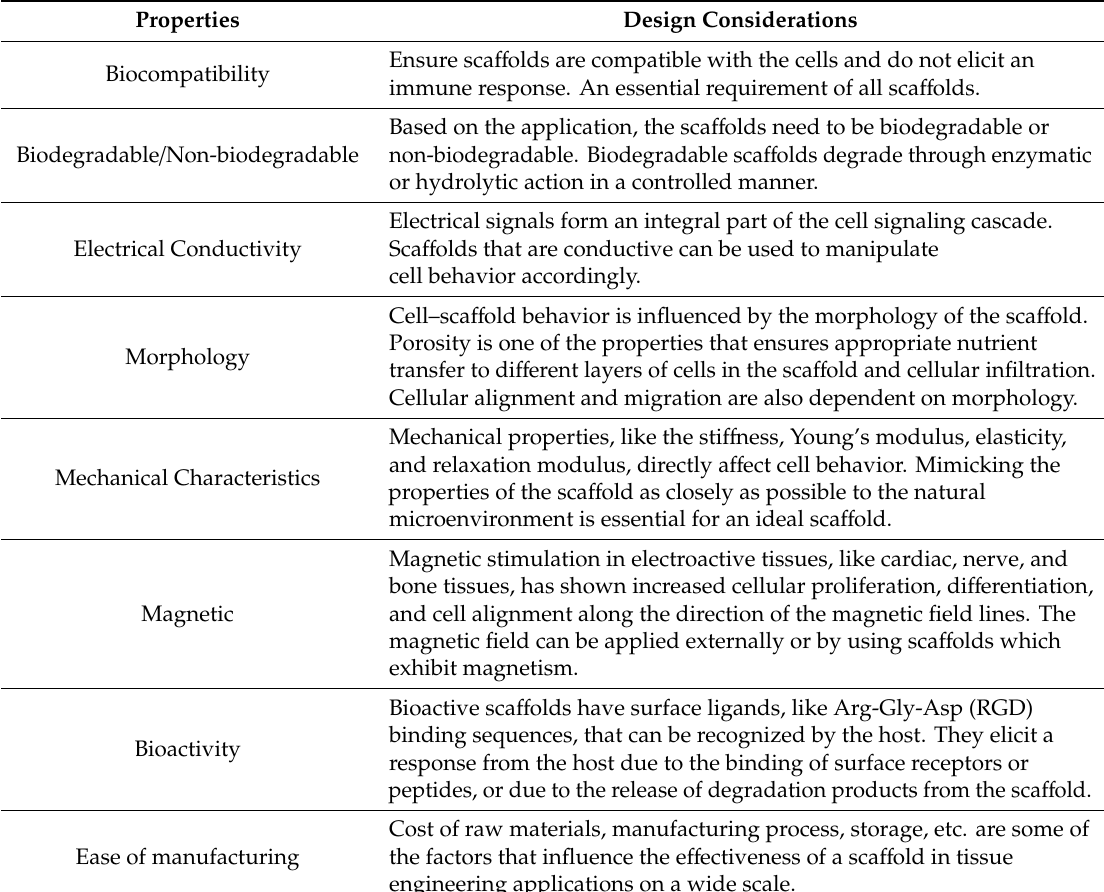
Table 1. Properties of the sca ff old considered when designing a sca ff